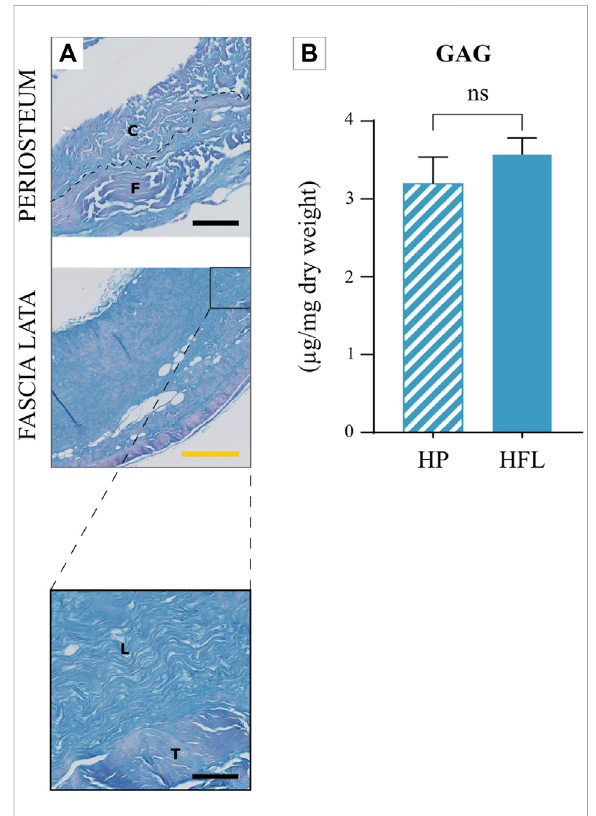
FIGURE 4 Comparison of HP and HFL (including zoom in) with alcian blue staining (A) and glycosaminoglycan quanti fi cation ( N = 4 donors x three samples from each donor leading to n = 12 specimens analyzed for each tissue) (B) . C: cambial layer, F: fi brous layer, L: longitudinal layer, T: transverse layer, HP: human periosteum, HFL: human fascia lata. Black scale bars: 100 µm. Yellow scale bar: 500 µm, ns: non-signi fi